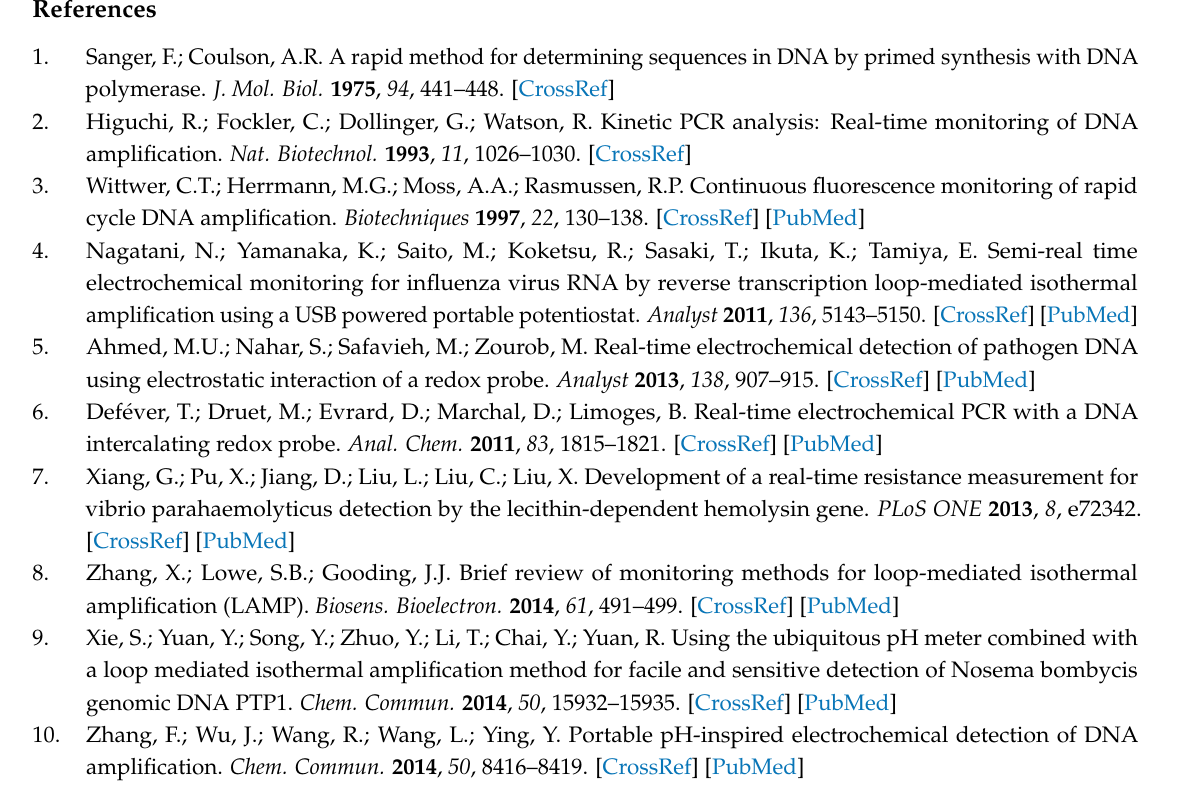
s1: Figure S1: Electropherograms of LAMP in the commercial or developed buffer; Figure S2: Temperature profiles after setting the temperature at 65 ◦